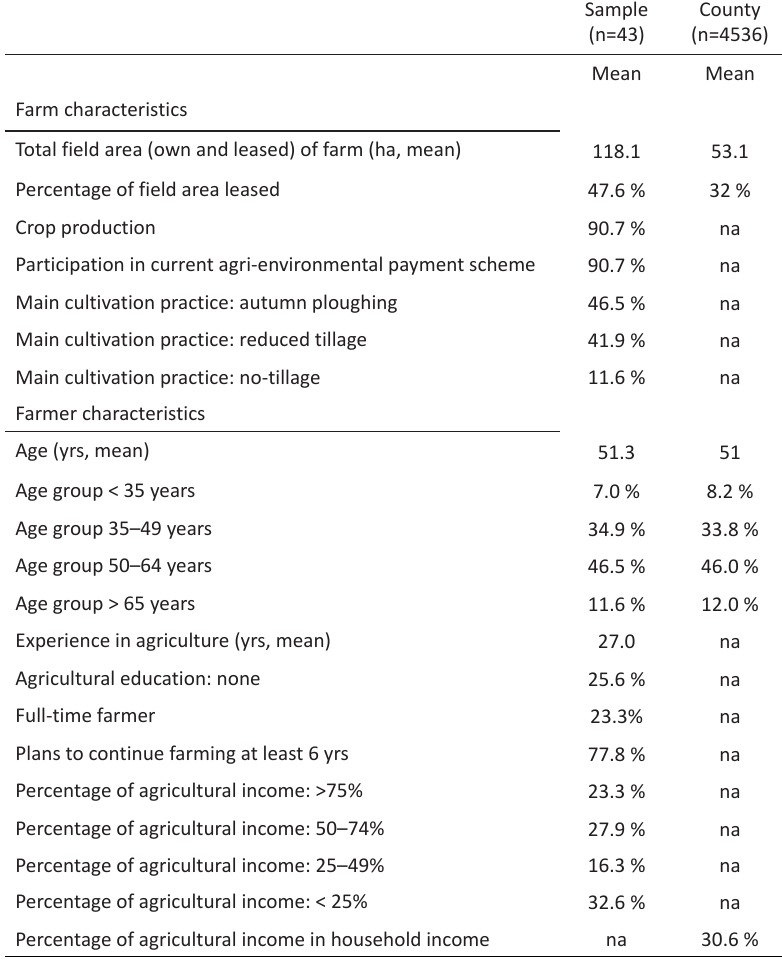
Table 1. Descriptive statistics of the sample and the county of Southwest